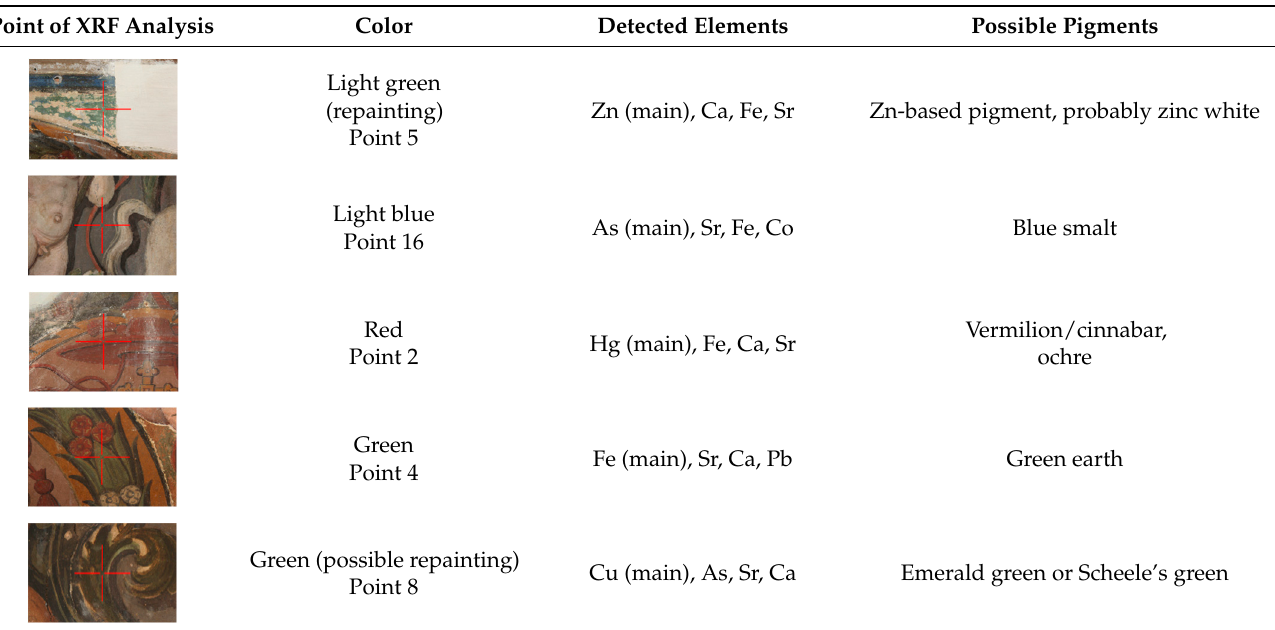
Table 1. Results of the XRF analysis on some of the areas inspected. A small photograph of the area is reported for clarity, together with a pinpoint for easy reading.